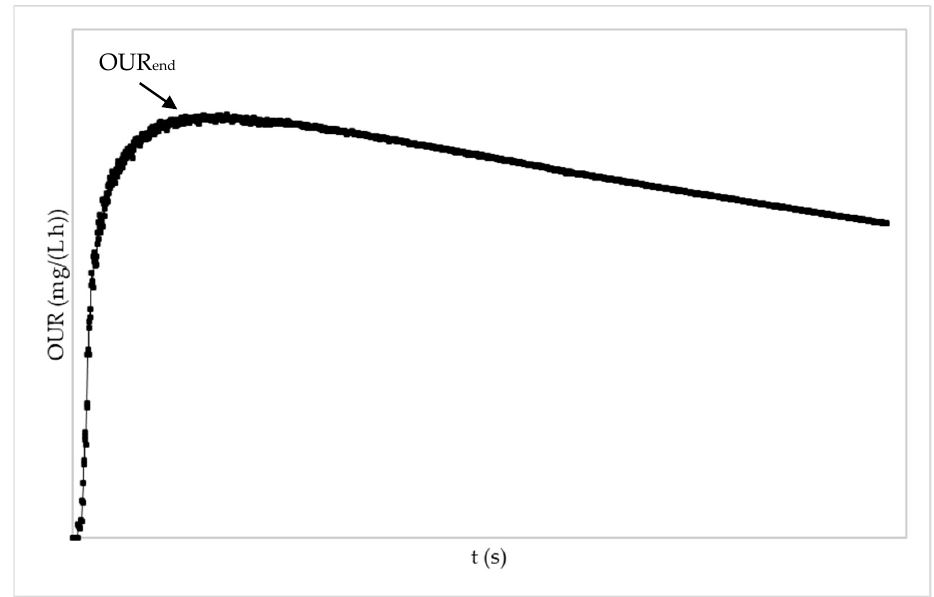
Figure 3. Evolution example of static oxygen uptake rate (OUR) in endogenous respirometric assay. OUR end : maximum rate of consumption in endogenous respiration assay.